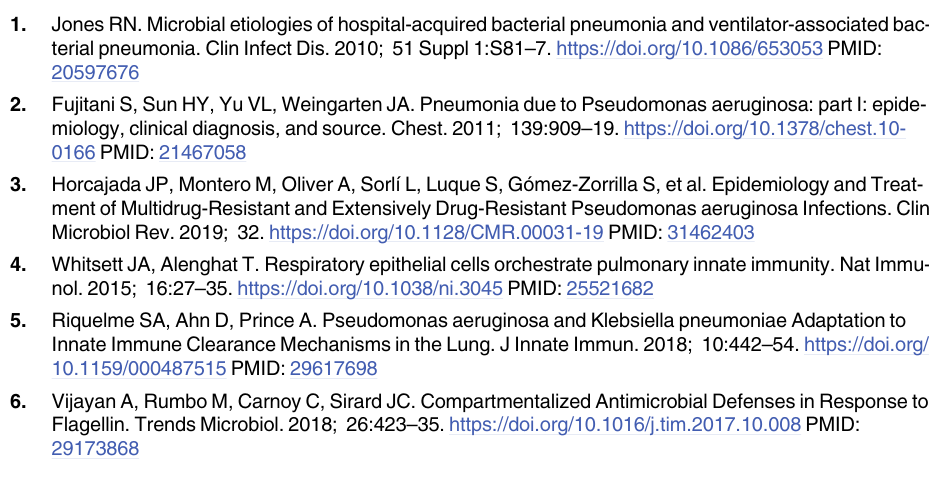
S7 Fig. Bronchial epithelial deficiency of Dnmt3b does not influence the host response during pneumonia caused by Klebsiella pneumoniae . (TIF) S8 Fig. Type II alveolar epithelial deficiency of Dnmt3b does not influence cytokine levels during pneumonia caused by P . aeruginosa . (TIF) S9 Fig. Gating strategy for neutrophils in BALF. S1 Table. Primers used for RT-qPCR in this study. S2 Table. Primers used for MeDIP and ChIP in this